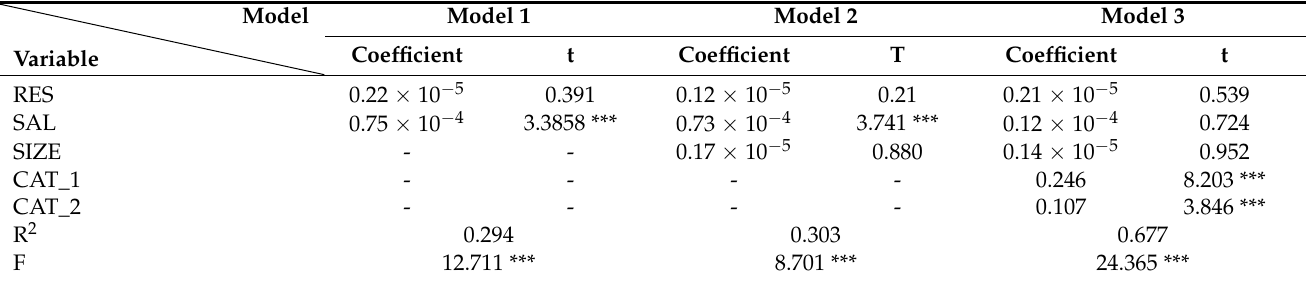
Table 4. Performance-reporting model